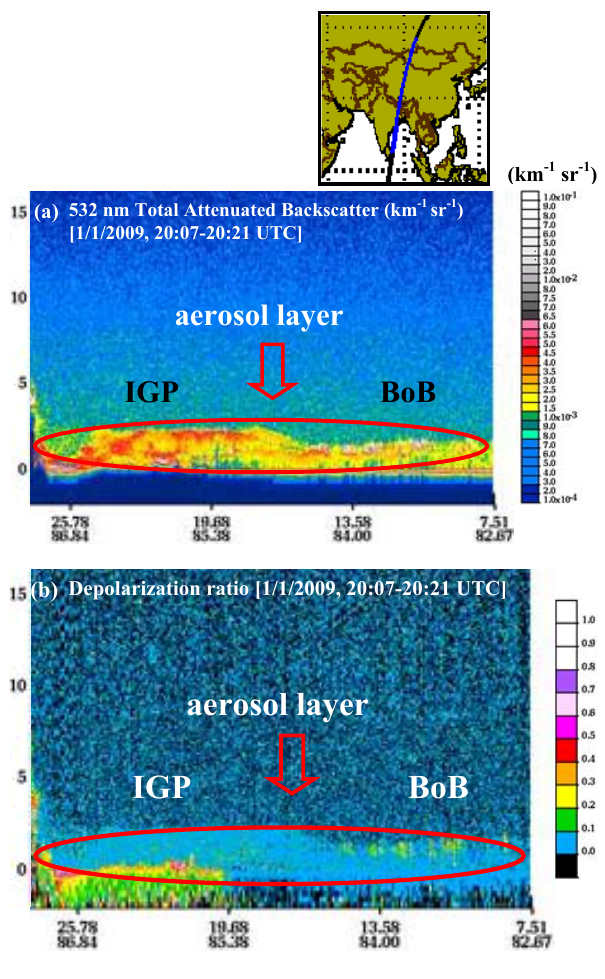
Fig. 7. Total attenuated backscatter profiles (km − 1 sr − 1 ) at 532nm (a) and depolarization ratio values (b) for nighttime con- ditions on 1 January 2009 obtained from CALIPSO observations. In the bottom of the figures the latitude (above) and the longitude (below) of the CALIPSO trajectory are also